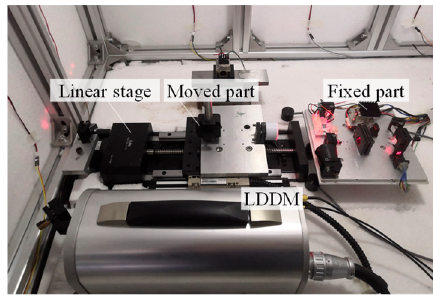
Figure 7. Experimental setup.